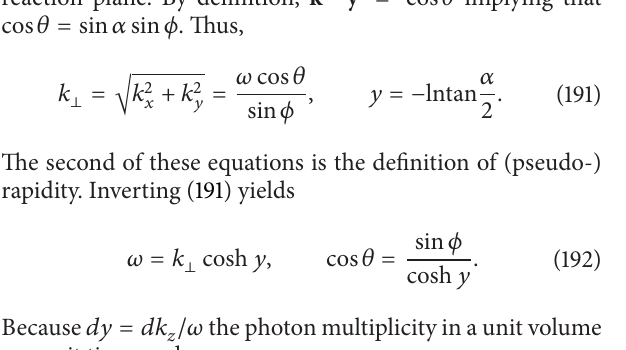
Figure 17: Azimuthal distribution of synchrotron radiation by 𝑢 - quarks at 𝑘 ⊥ = 0.2 GeV, 𝑒𝐵 = 𝑚 2 𝜋 , and 𝑦 = 0. 𝑚 𝑢 = 3 MeV. Adopted from